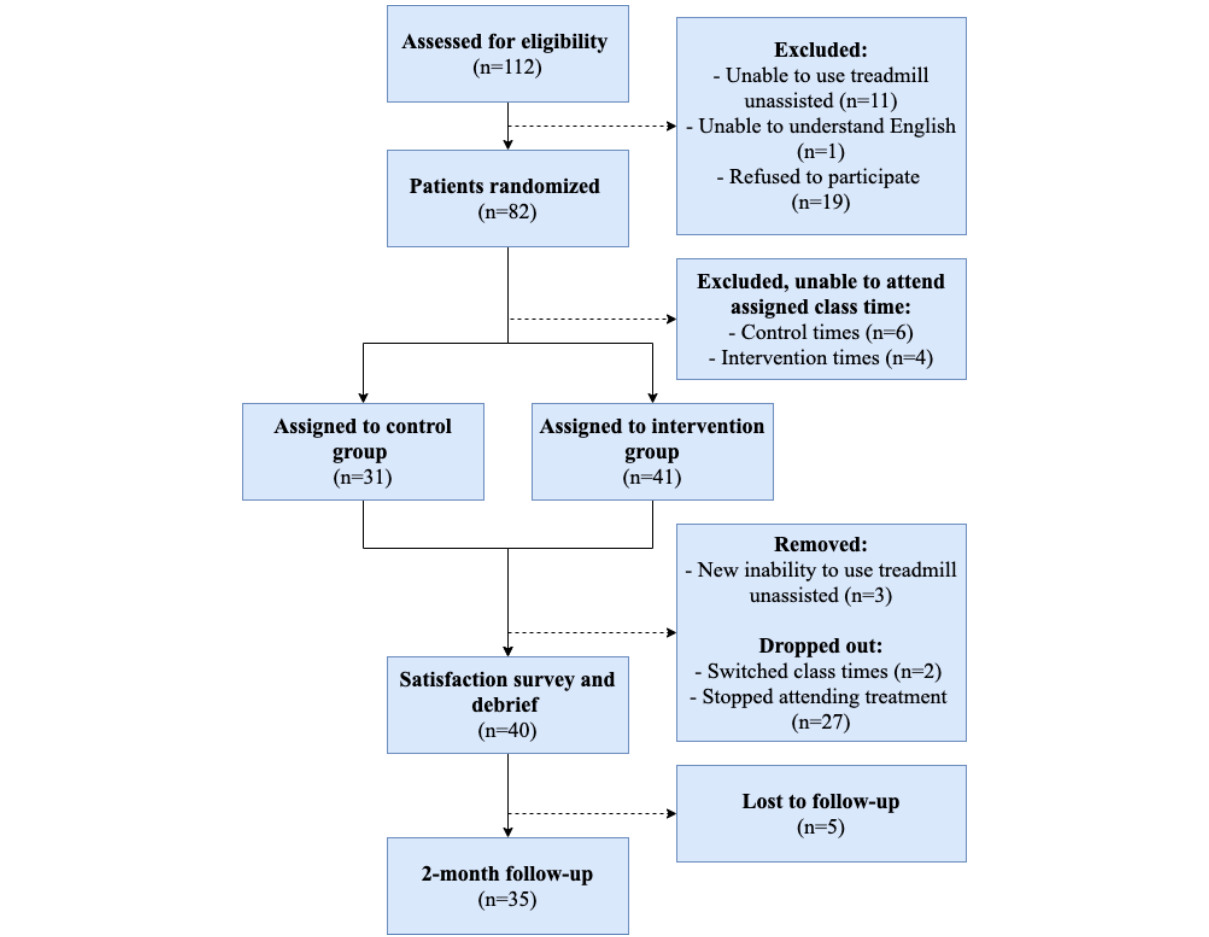
Figure 2. Flow diagram of research design and patient completion